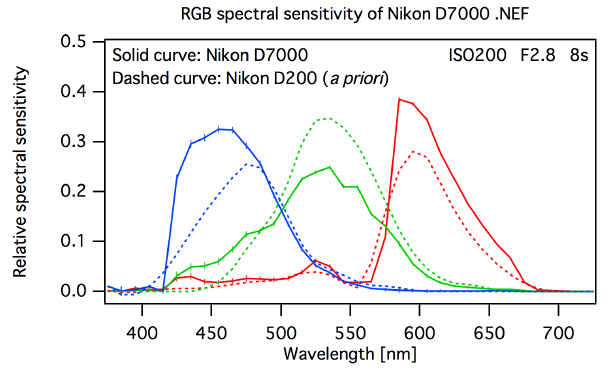
Figure 2. Inferred color-matching functions of Nikon D7000 in this study (solid lines) and of D200 (dotted lines) from Sigarnes et al. (2008).